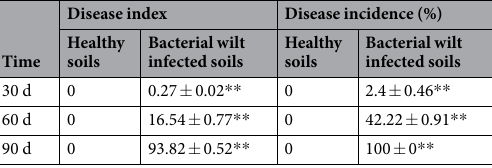
Table 3. Disease incidence of tobacco bacterial wilt. ** Significant at p < 0.01